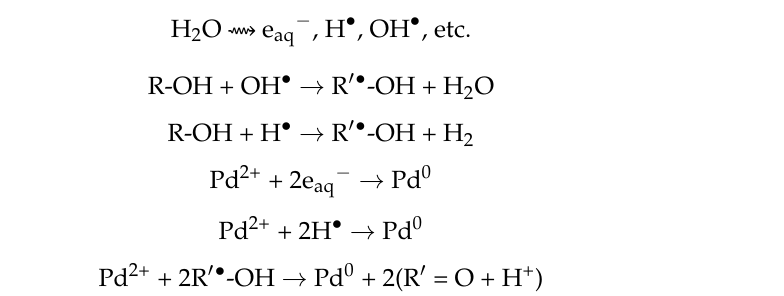
Figure 4. Peel strength of the Cu film on the Pd/ABS. Control sample was prepared by the conven- tional plating method using hexavalent chromic acid. The dotted line represents 0.7 N/mm.